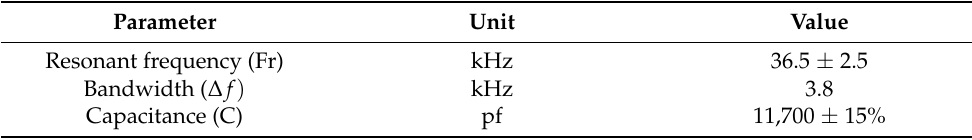
Table 2. Material properties of PZT-43 used for the PZT hemispherical hydrophone.